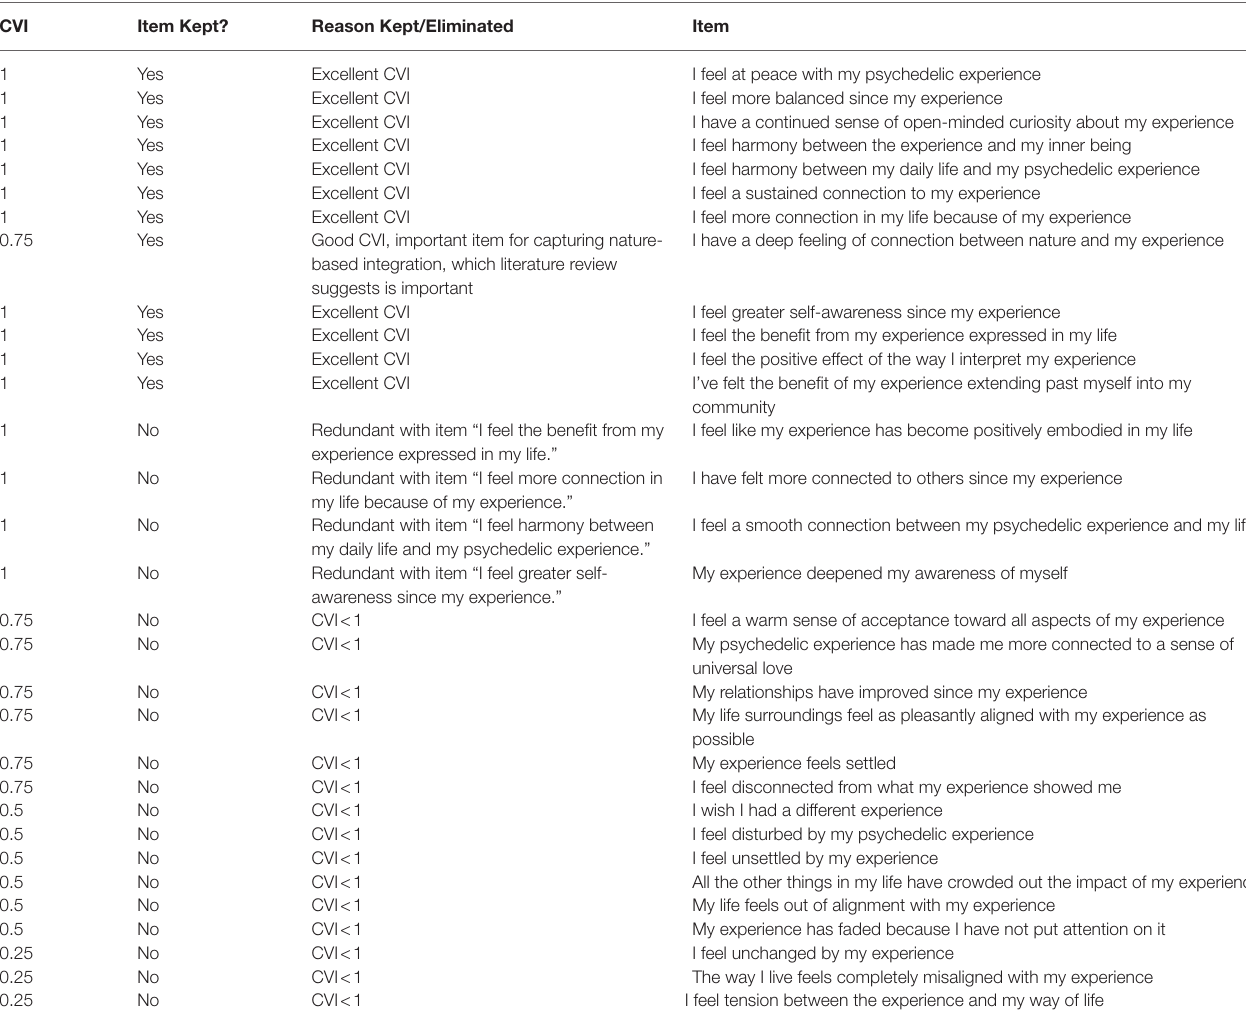
TABLE 7 | Item filtration for the experienced integration scale item